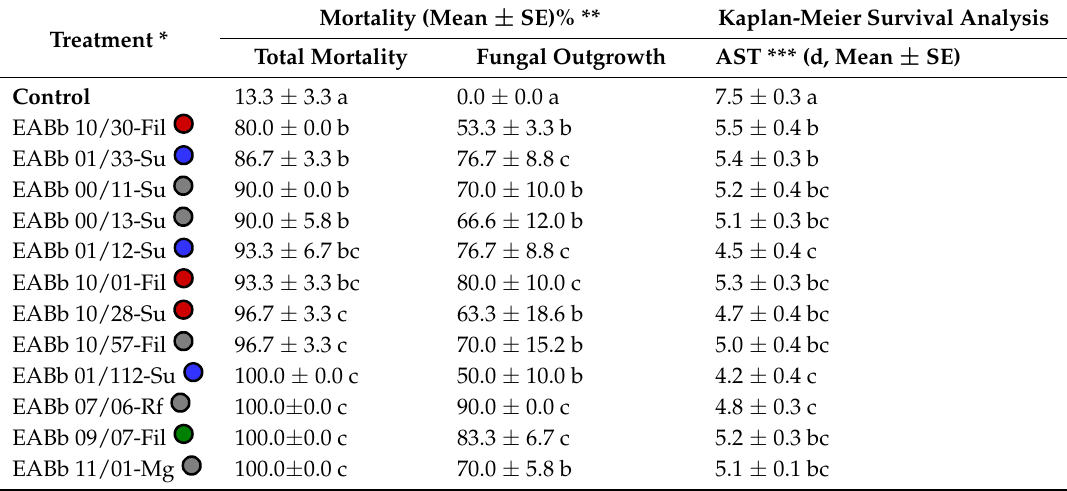
* Grey circles indicate that the isolate is infected with all three BbPV-2-like, BbVV-1-like, and BbPmV-1-like viruses; *Grey circles indicate that the isolate is infected with all three BbPV‐2‐like, BbVV‐1‐like, and BbPmV‐ single infections of isolates are indicated by blue circles for BbVV-1-like virus, green circles for BbPV-2-like virus 1‐like viruses; single infections of isolates are indicated by blue circles for BbVV‐1‐like virus, green and red circles for BbPmV-1-like virus. ** Means within columns with the same letter are not significantly different ( χ 2 test, p ≤ 0.05) according to the generalised linear model. *** AST: Average survival time was limited to 8 days. circles for BbPV‐2‐like virus and red circles for BbPmV‐1‐like virus. ** Means within columns with *Grey circles indicate that the isolate is infected with all three BbPV‐2‐like, BbVV‐1‐like, and BbPmV‐ Means within columns with the same letter are not significantly different ( p ≤ 0.05) according to the Log-Rank test. *Grey circles indicate that the isolate is infected with all three BbPV‐2‐like, BbVV‐1‐like, and BbPmV‐ the same letter are not significantly different (  2 test, p ≤ 0.05) according to the generalised linear *Grey circles indicate that the isolate is infected with all three BbPV‐2‐like, BbVV‐1‐like, and BbPmV‐ *Grey circles indicate that the isolate is infected with all three BbPV‐2‐like, BbVV‐1‐like, and BbPmV‐ 1‐like viruses; single infections of isolates are indicated by blue circles for BbVV‐1‐like virus, green 1‐like viruses; single infections of isolates are indicated by blue circles for BbVV‐1‐like virus, green model. *** AST: Average survival time was limited to 8 days. Means within columns with the same 1‐like viruses; single infections of isolates are indicated by blue circles for BbVV‐1‐like virus, green 1‐like viruses; single infections of isolates are indicated by blue circles for BbVV‐1‐like virus, green circles for BbPV‐2‐like virus and red circles for BbPmV‐1‐like virus. ** Means within columns with circles for BbPV‐2‐like virus and red circles for BbPmV‐1‐like virus. ** Means within columns with Supplementary Materials: The following are available online at http://www.mdpi.com/1999-4915/10/12/665/ letter are not significantly different ( p ≤ 0.05) according to the Log‐Rank test. circles for BbPV‐2‐like virus and red circles for BbPmV‐1‐like virus. ** Means within columns with circles for BbPV‐2‐like virus and red circles for BbPmV‐1‐like virus. ** Means within columns with the same letter are not significantly different (  2 test, p ≤ 0.05) according to the generalised linear *Grey circles indicate that the isolate is infected with all three BbPV‐2‐like, BbVV‐1‐like, and BbPmV‐ s1. Figure S1. Pairwise distance matrix created based on the RdRp sequences of chrysoviruses and related the same letter are not significantly different (  2 test, p ≤ 0.05) according to the generalised linear the same letter are not significantly different (  2 test, p ≤ 0.05) according to the generalised linear the same letter are not significantly different (  2 test, p ≤ 0.05) according to the generalised linear viruses; (A) members of the family Partitiviridae , (B) members of the family Totiviridae and (C) members of the model. *** AST: Average survival time was limited to 8 days. Means within columns with the same 1‐like viruses; single infections of isolates are indicated by blue circles for BbVV‐1‐like virus, green model. *** AST: Average survival time was limited to 8 days. Means within columns with the same model. *** AST: Average survival time was limited to 8 days. Means within columns with the same proposed family Polymycoviridae infecting Beauveria bassiana . Figure S2: Schematic representation of potential *Grey circles indicate that the isolate is infected with all three BbPV‐2‐like, BbVV‐1‐like, and BbPmV‐ model. *** AST: Average survival time was limited to 8 days. Means within columns with the same letter are not significantly different ( p ≤ 0.05) according to the Log‐Rank test. circles for BbPV‐2‐like virus and red circles for BbPmV‐1‐like virus. ** Means within columns with letter are not significantly different ( p ≤ 0.05) according to the Log‐Rank test. *Grey circles indicate that the isolate is infected with all three BbPV‐2‐like, BbVV‐1‐like, and BbPmV‐ recombination events between two BbPmV-1 strains: BbPmV-1 strain EABb 10/30-Fil is a recombinant of BbPmV-1 letter are not significantly different ( p ≤ 0.05) according to the Log‐Rank test. 1‐like viruses; single infections of isolates are indicated by blue circles for BbVV‐1‐like virus, green letter are not significantly different ( p ≤ 0.05) according to the Log‐Rank test. the same letter are not significantly different (  2 test, p ≤ 0.05) according to the generalised linear *Grey circles indicate that the isolate is infected with all three BbPV‐2‐like, BbVV‐1‐like, and BbPmV‐ strain EABb 11/01-Mg (major parent) and BbPmV-1 strain EABb 10/28-Su (minor parent). Recombination 1‐like viruses; single infections of isolates are indicated by blue circles for BbVV‐1‐like virus, green *Grey circles indicate that the isolate is infected with all three BbPV‐2‐like, BbVV‐1‐like, and BbPmV‐ circles for BbPV‐2‐like virus and red circles for BbPmV‐1‐like virus. ** Means within columns with *Grey circles indicate that the isolate is infected with all three BbPV‐2‐like, BbVV‐1‐like, and BbPmV‐ breakage sites are indicated. Figure S3. Maximum likelihood phylogenetic tree created based on the alignment model. *** AST: Average survival time was limited to 8 days. Means within columns with the same 1‐like viruses; single infections of isolates are indicated by blue circles for BbVV‐1‐like virus, green circles for BbPV‐2‐like virus and red circles for BbPmV‐1‐like virus. ** Means within columns with 1‐like viruses; single infections of isolates are indicated by blue circles for BbVV‐1‐like virus, green the same letter are not significantly different (  2 test, p ≤ 0.05) according to the generalised linear 1‐like viruses; single infections of isolates are indicated by blue circles for BbVV‐1‐like virus, green letter are not significantly different ( p ≤ 0.05) according to the Log‐Rank test. circles for BbPV‐2‐like virus and red circles for BbPmV‐1‐like virus. ** Means within columns with the same letter are not significantly different (  2 test, p ≤ 0.05) according to the generalised linear *Grey circles indicate that the isolate is infected with all three BbPV‐2‐like, BbVV‐1‐like, and BbPmV‐ circles for BbPV‐2‐like virus and red circles for BbPmV‐1‐like virus. ** Means within columns with model. *** AST: Average survival time was limited to 8 days. Means within columns with the same circles for BbPV‐2‐like virus and red circles for BbPmV‐1‐like virus. ** Means within columns with the same letter are not significantly different (  2 test, p ≤ 0.05) according to the generalised linear model. *** AST: Average survival time was limited to 8 days. Means within columns with the same 1‐like viruses; single infections of isolates are indicated by blue circles for BbVV‐1‐like virus, green the same letter are not significantly different (  2 test, p ≤ 0.05) according to the generalised linear letter are not significantly different ( p ≤ 0.05) according to the Log‐Rank test. the same letter are not significantly different (  2 test, p ≤ 0.05) according to the generalised linear model. *** AST: Average survival time was limited to 8 days. Means within columns with the same letter are not significantly different ( p ≤ 0.05) according to the Log‐Rank test. circles for BbPV‐2‐like virus and red circles for BbPmV‐1‐like virus. ** Means within columns with model. *** AST: Average survival time was limited to 8 days. Means within columns with the same model. *** AST: Average survival time was limited to 8 days. Means within columns with the same letter are not significantly different ( p ≤ 0.05) according to the Log‐Rank test. the same letter are not significantly different (  2 test, p ≤ 0.05) according to the generalised linear letter are not significantly different ( p ≤ 0.05) according to the Log‐Rank test. letter are not significantly different ( p ≤ 0.05) according to the Log‐Rank test. model. *** AST: Average survival time was limited to 8 days. Means within columns with the same letter are not significantly different ( p ≤ 0.05) according to the Log‐Rank test.